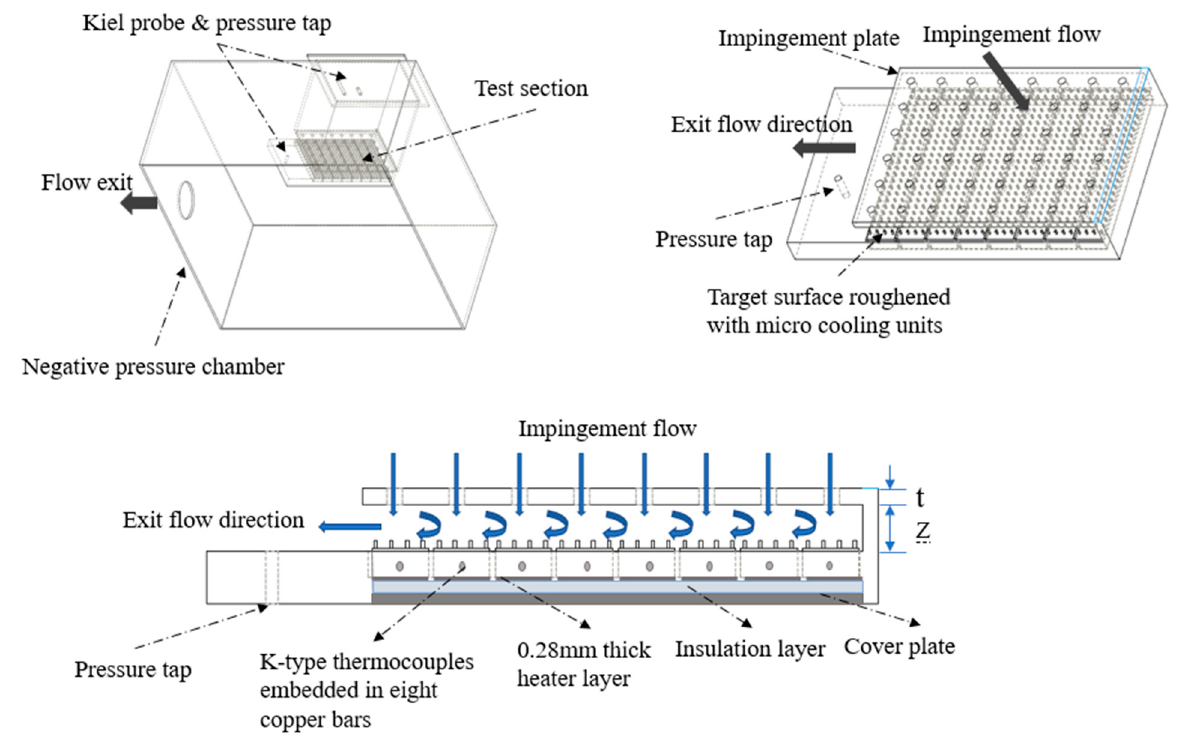
Figure 2. Diagram of test section.